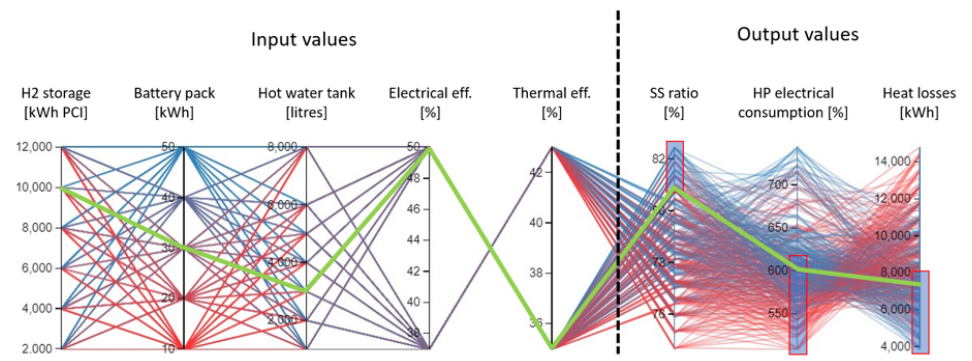
Figure 3. Sized system from Design